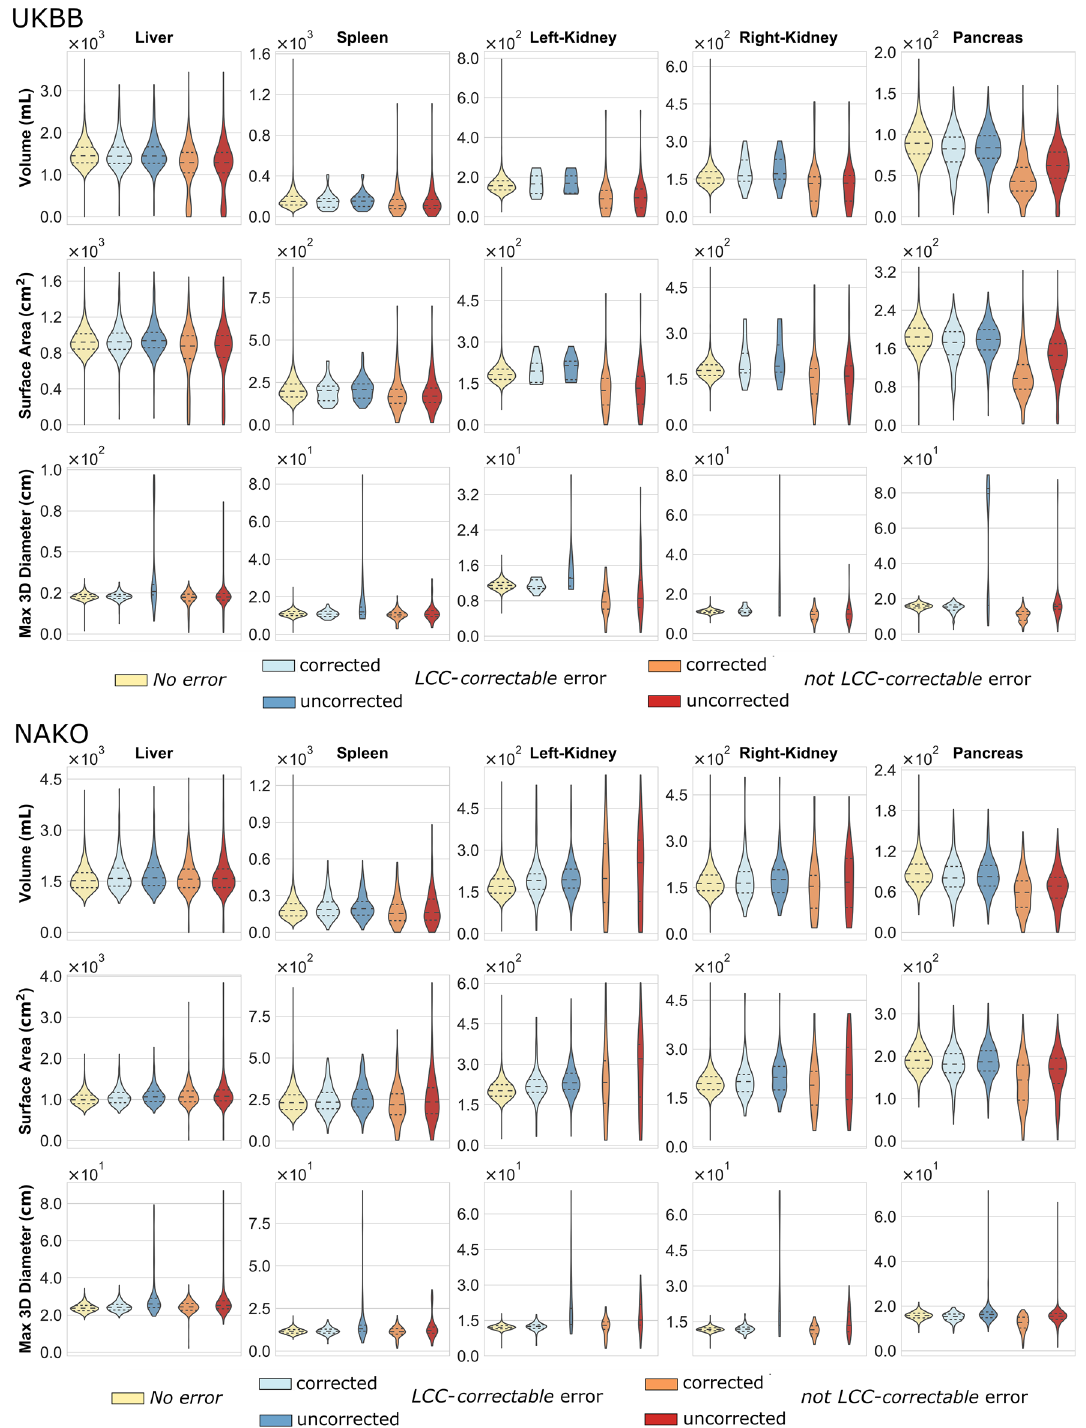
Figure 3. Impact of segmentation errors on extracted features (Top: UKBB, Bottom: NAKO). Comparison of segmentation mask categories (from left to right within each subplot: without error (yellow), corrected largest connected component ( LCC) - correctable error (dark blue), uncorrected LCC - correctable error (light blue), corrected not LCC - correctable error (dark red), uncorrected not LCC - correctable error (light red) across organs (subplots from left to right: liver, spleen, left kidney, right kidney, pancreas) and across shape features (subplots from top to bottom: volume, surface area, maximum 3D